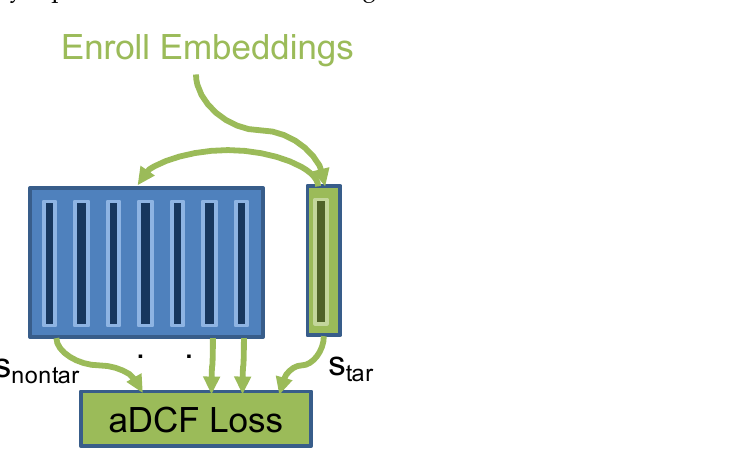
Figure 1. Training face enrollment models using target and nontarget embeddings for each enroll or target